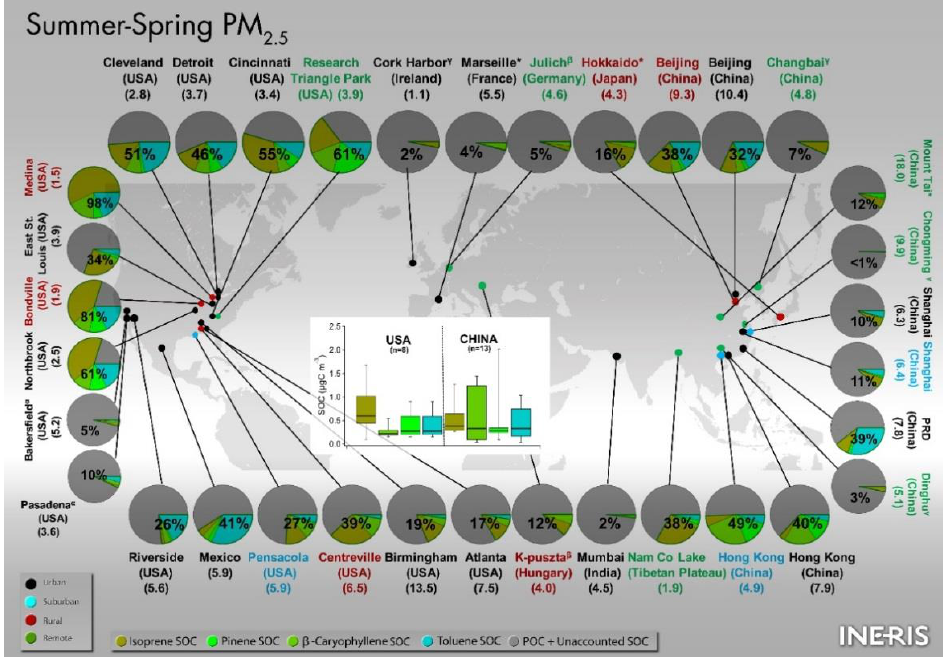
Figure 6. Spring–summer SOC contributions to PM 2.5 OC over the world for all the selected sites from 2006 to 2016 using the SOA tracer method. OC concentrations (µgC m −3 ) for each site are indicated into brackets. Box-plots represent the SOC concentrations (µgC m −3 ) for USA and China. Box plots include minimum (10th), first quartile (25th), median (50th), third quartile (75th) and maximum values (90th). The number of data points considered is presented into brackets on the box-plot graphs. * Toluene SOC was not reported at these locations. α β-caryophyllene SOC was not reported at these locations. β Toluene SOC and β-caryophyllene SOC were not reported at these locations. γ Only isoprene SOC was reported at these locations. Details about the unaccounted SOC is given in the main text (Section 3.3.3).